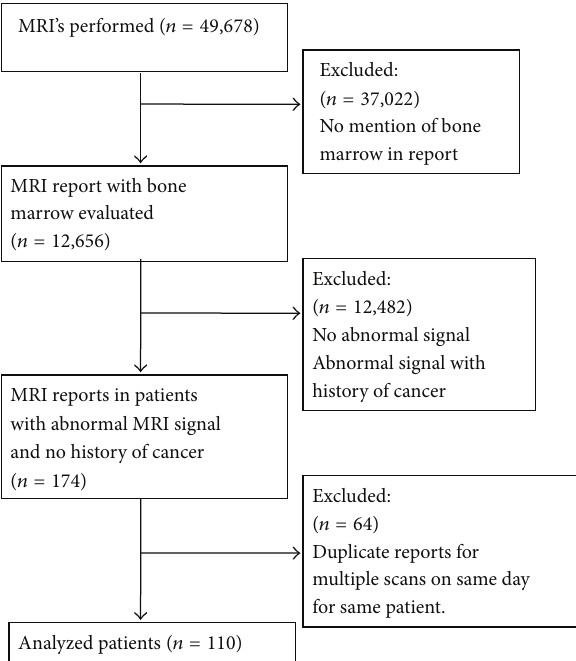
Figure 1: Flow diagram of